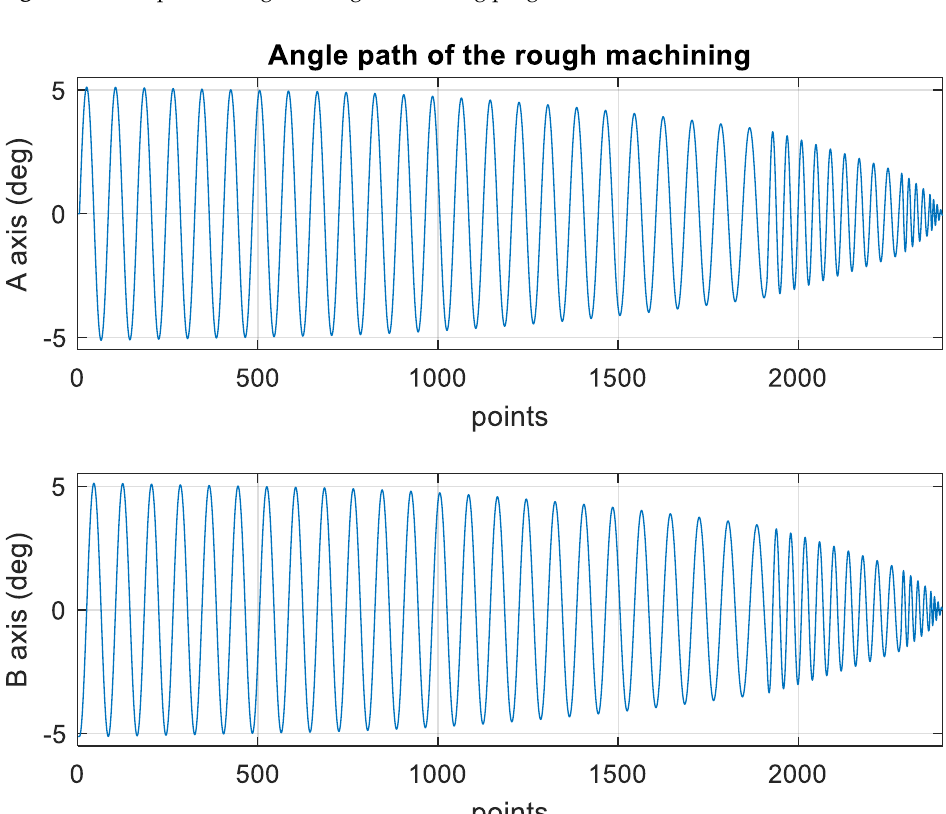
Figure 11. Angle path of the original rough machining program.